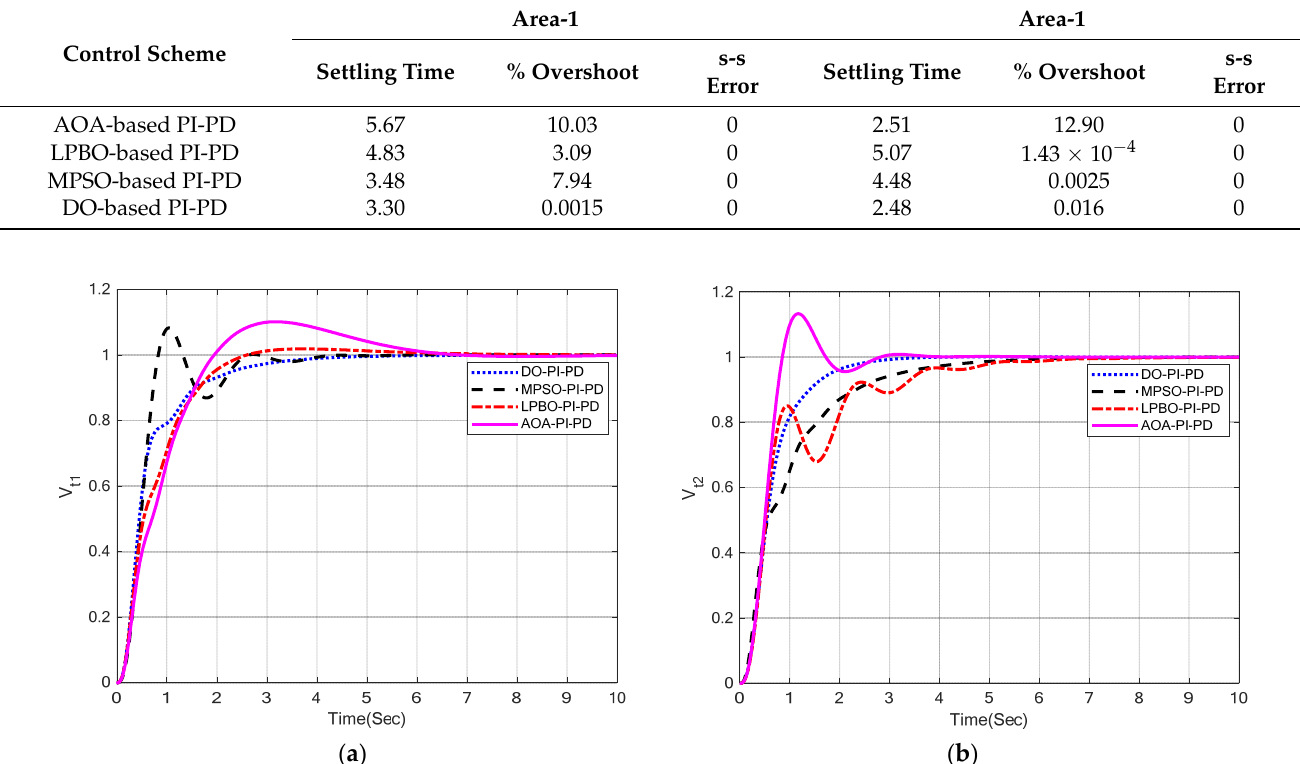
Figure 12. AVR responses in a two-area multi-source realistic IPS with nonlinearities.( a ) V t1 ;( b ) V t2. Table 10. Numerical results of an AVR in a two-area multi-source realistic IPS with nonlinearities.